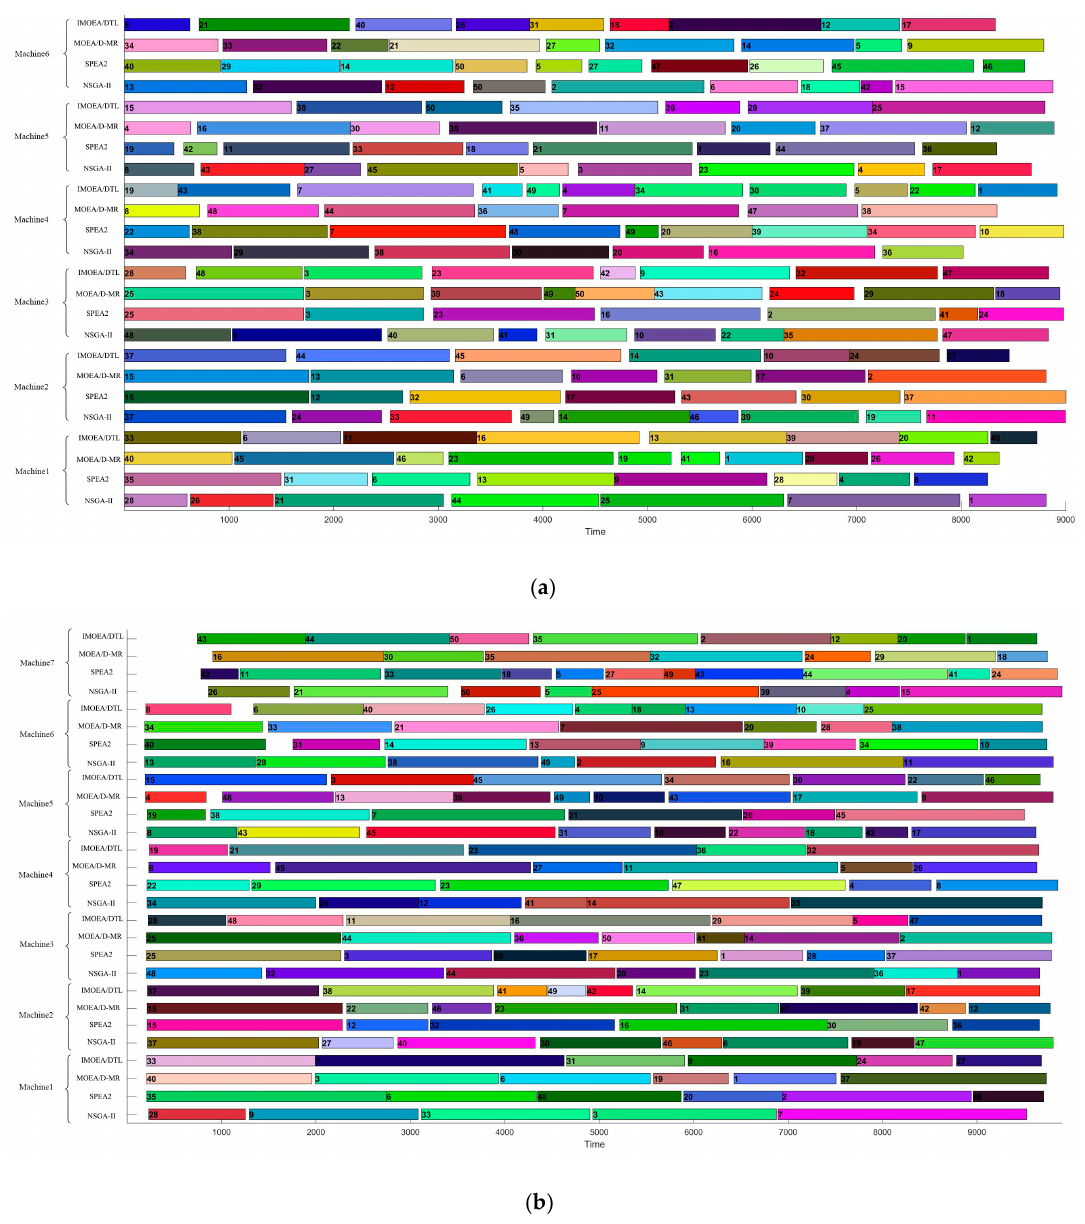
Figure 4. The Gantt charts of Job1, ( a , b ) are Gantt charts of the first and second operation of Job1, respectively; the makespan and energy cost of NSGA-II, SPEA2, MOEA/D-MR, and IMOEA/DTL are (9.9020 × 10 3 , 8.1231 × 10 5 ), (9.8583 × 10 3 , 8.1278 × 10 5 ), (9.8063 × 10 3 , 8.1155 × 10 5 ), and (9.6900 × 10 3 , 8.1150 × 10 5 ) respectively.